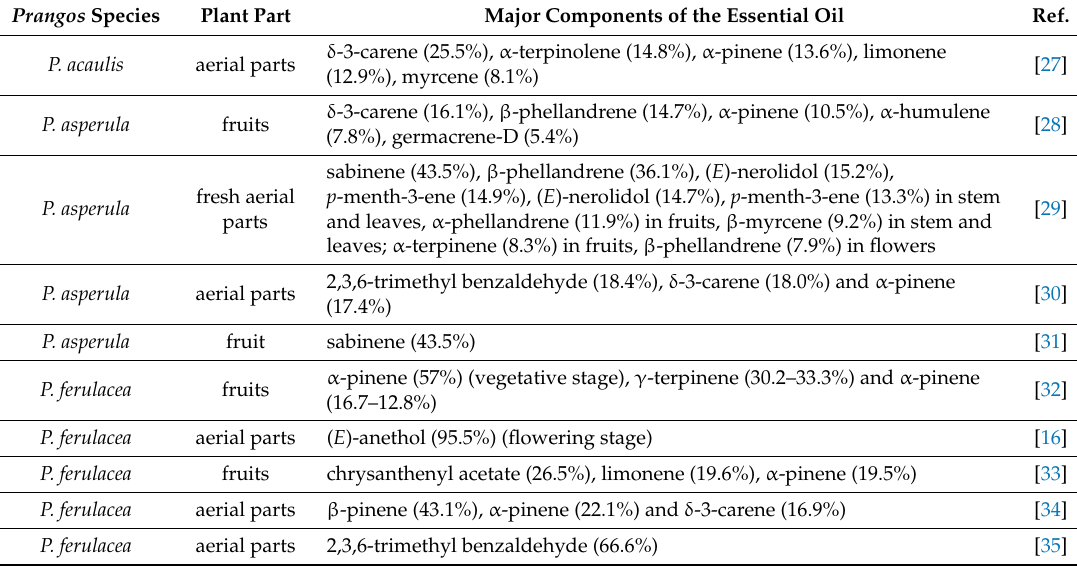
Table 2. The major compounds reported as chemical composition of essential oil from Prangos